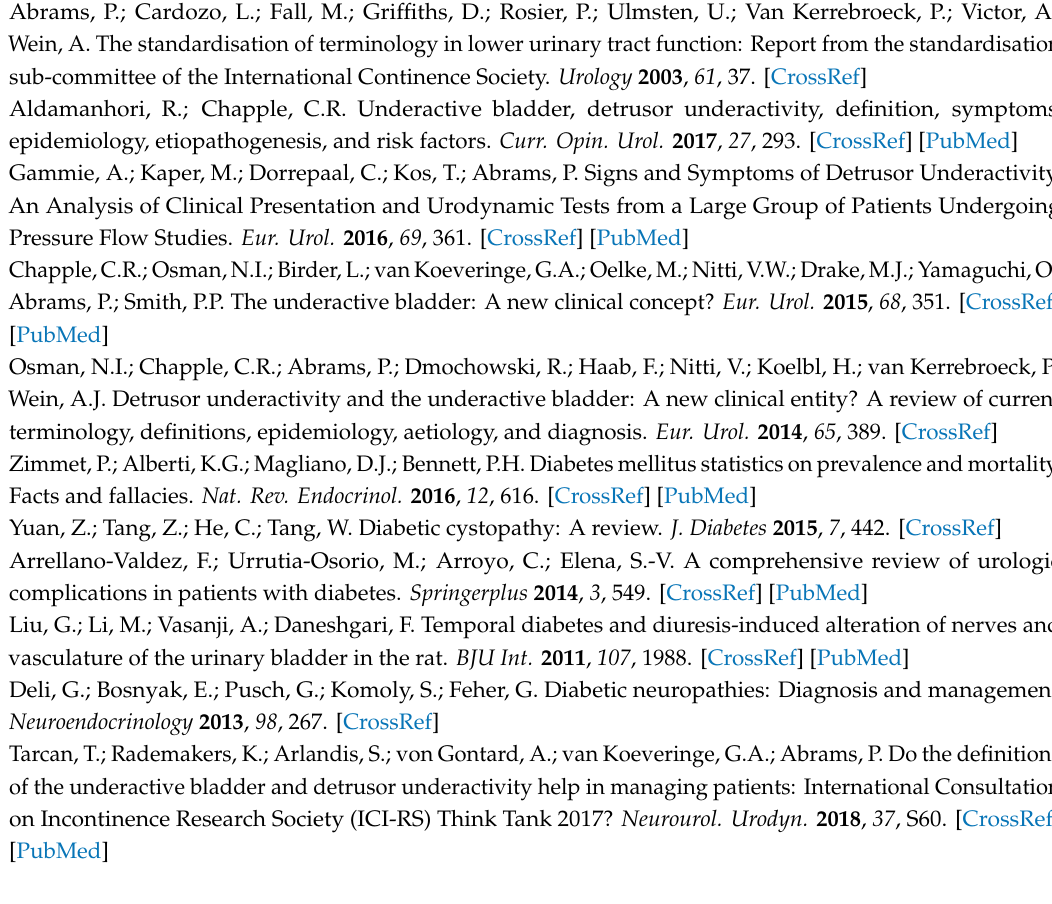
Figure S1: Surface phenotype of M-MSCs and UC-MSCs. Figure S2: Immunostaining of caspase 7 protein in DM bladders. Figure S3: Long-term e ff ect of M-MSC therapy on the expression of genes related to diabetic